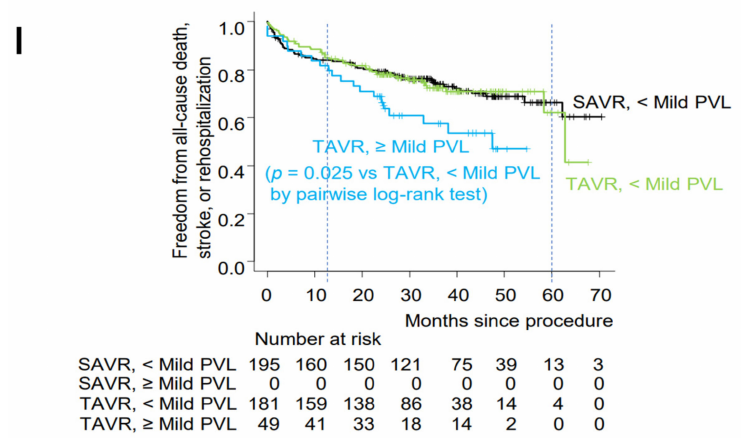
Figure 3. Kaplan–Meier curves showing freedom from all-cause death, stroke or rehospitalization. Patients were stratified by ( A ) study group, ( B ) with or without moderate or greater patient–prosthesis mismatch (PPM), ( C ) with or without moderate or greater PPM and study group, ( D ) with or without severe PPM, ( E ) with or without severe PPM and study group, ( F ) with or without paravalvular leakage (PVL), ( G ) with or without PVL and study group, ( H ) with or without mild or greater PVL, ( I ) with or without mild or greater PVL and study group. EOAI: effective orifice area index, NS: